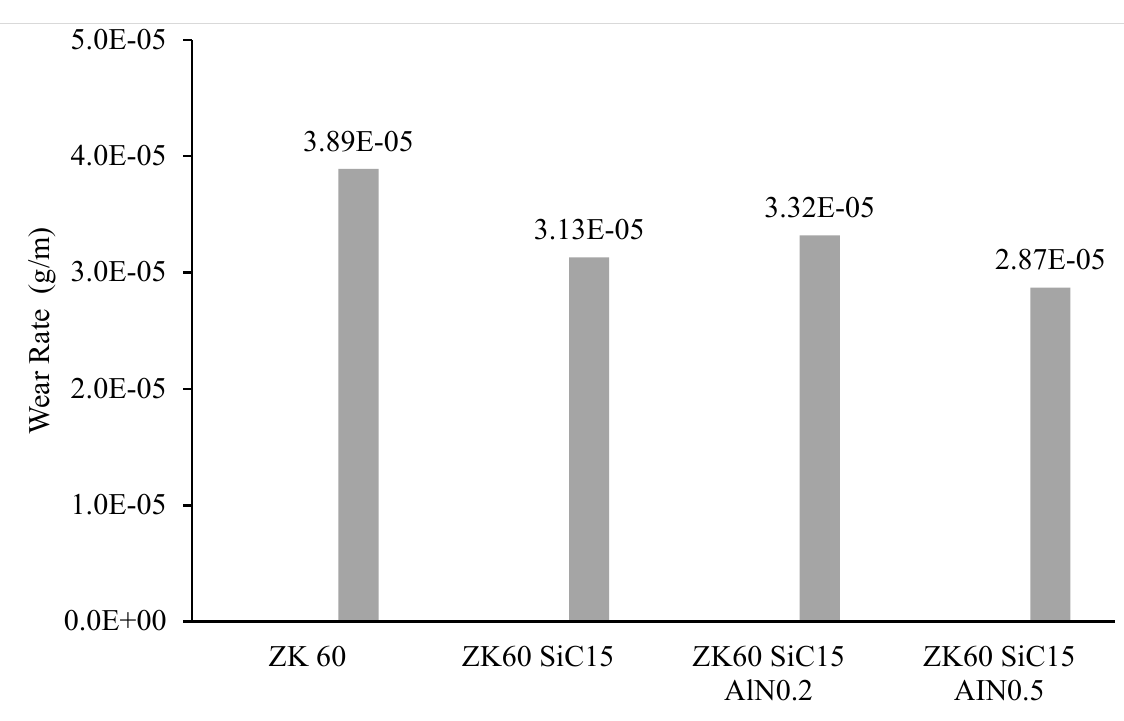
Figure 12. Dry wear test results of the unreinforced ZK60 and the reinforced composites.